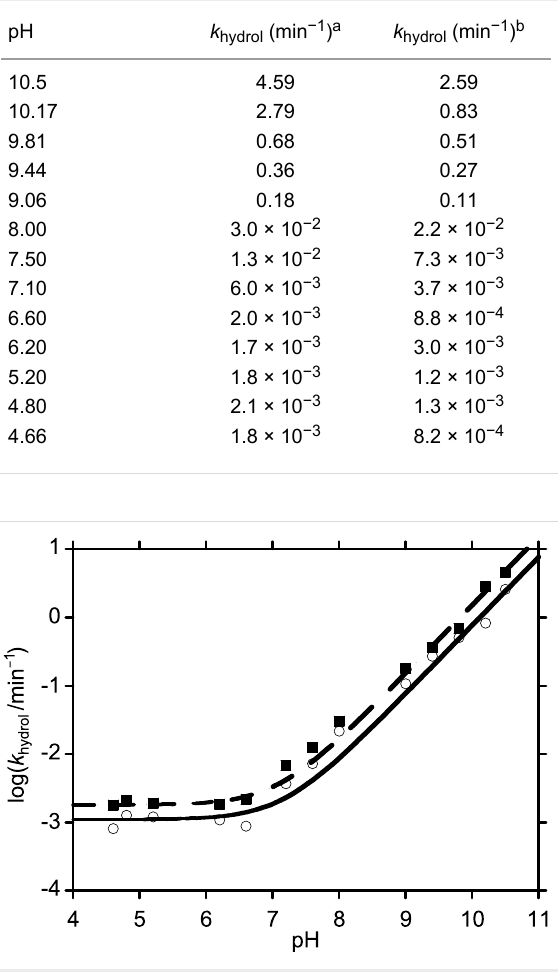
Figure 1: log k hydrol vs pH for the hydrolysis p -nitrophenyl ester 7 (R = p NP) and m -nitrophenyl ester 7 (R = m NP) at 25 °C. Squares corres- pond to data for p -nitrophenyl ester 7 (R = p NP); circles correspond to data for m -nitrophenyl ester 7 (R = m NP). The dashed line corre- sponds to data fitting for p -nitrophenyl ester 7 (R = p NP) and the solid line corresponds to data fitting for m -nitrophenyl ester 7 (R = m NP).